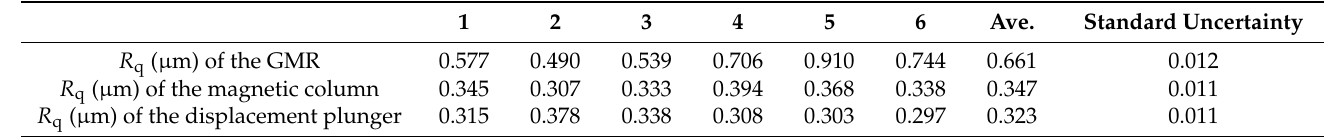
Figure 9. Rough surface morphology for the ( a ) GMR, ( b ) magnetic column, ( c ) and displacement plunger. The measurement data and the standard uncertainty of measurement are displayed in Table 1. For a three-dimensional rough surface, R q represent the RMSE of roughness. Table 1. Measurement parameters R q and standard uncertainty of rough surfaces.